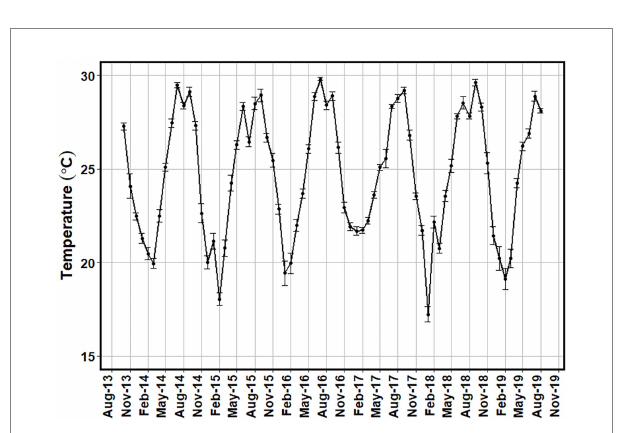
FIGURE 3 Monthly average surface temperature ( ° C) for the study region from MODIS-Aqua satellite from October 2013 to August